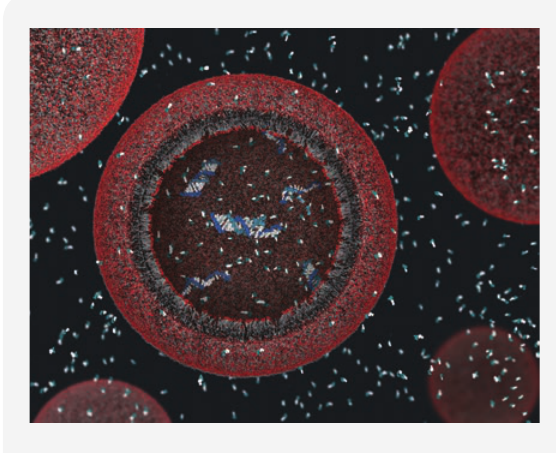
Figure 1. Illustration of a model protocell, consisting of a lipid mem- brane encapsulating small pieces of an RNA-like genetic material. The protocell is shown in a rich chemical environment fi lled with nucleo- tides and other building blocks of life. Image courtesy of Janet Iwasa.